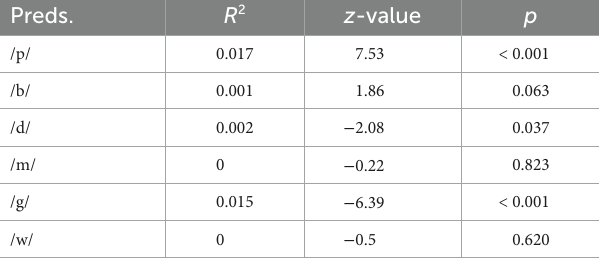
TABLE 5 Results of the second generalized linear mixed-effects model applied to all samples with unique phoneme counts.